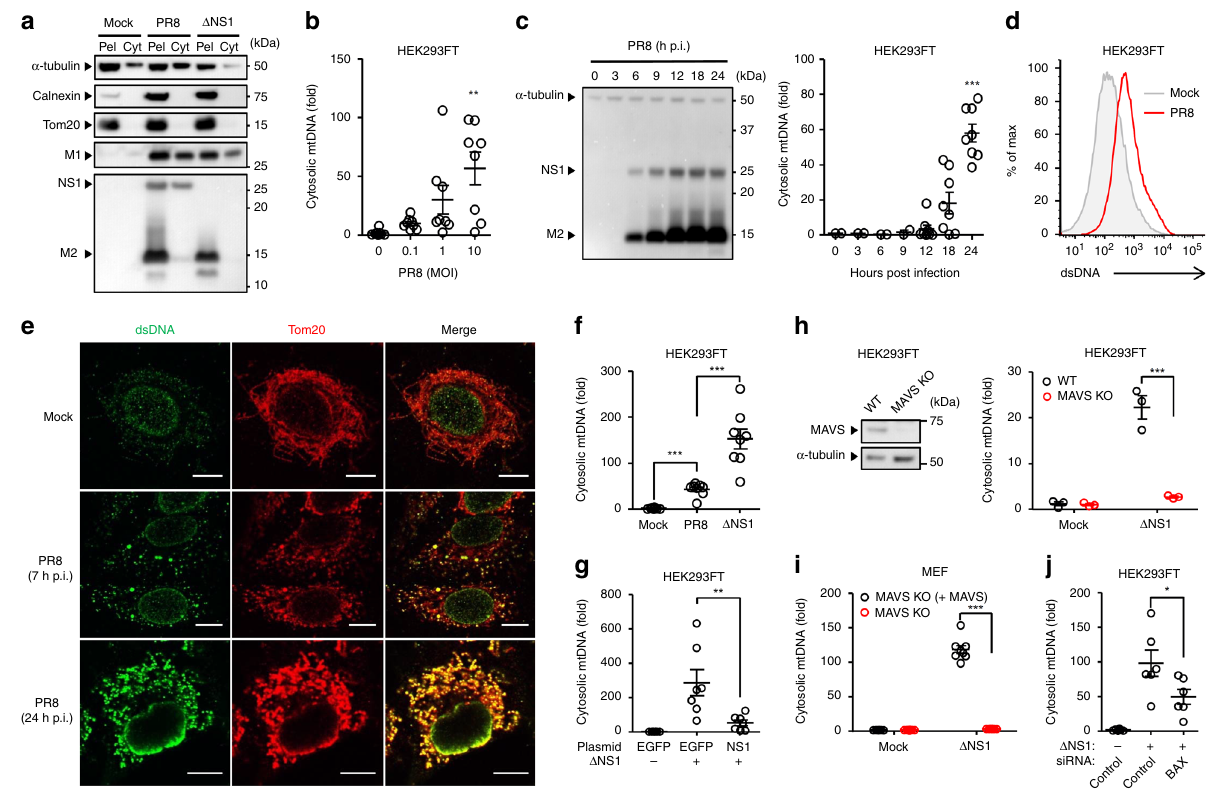
Fig. 1 In fl uenza virus triggers mtDNA release. a HEK293FT cells were subjected to digitonin fractionation as described in the Methods and pellets (Pel) or cytosolic extracts (Cyt) were analyzed by western blotting using the indicated antibodies. b HEK293FT cells were infected with PR8 virus at indicated MOIs. Cytosolic mtDNA was assessed by quantitative PCR. c HEK293FT cells were infected with PR8 virus at MOI of 10. Cell lysates were collected at indicated time points and analyzed by immunoblotting with indicated antibodies (left panel). Cytosolic mtDNA was assessed by quantitative PCR (right panel). d HEK293FT were infected with PR8 virus. Cells were collected at 24 h post infection, and intracellularly stained with dsDNA-speci fi c